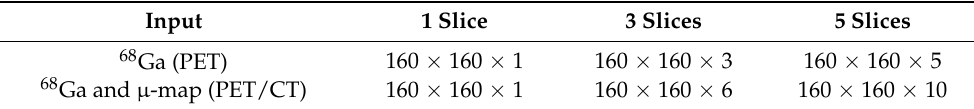
Table 1. Sizes of the input layers for the different evaluated cases of the Deep-PRC